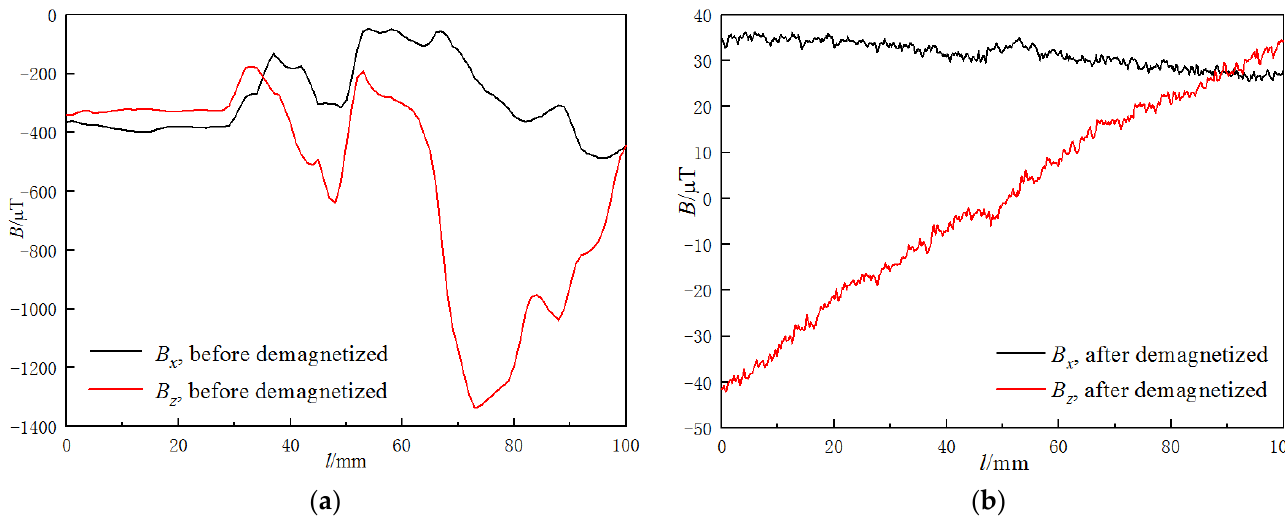
Figure 2. MMMT signals of the specimen ( a ) before and ( b ) after demagnetization.